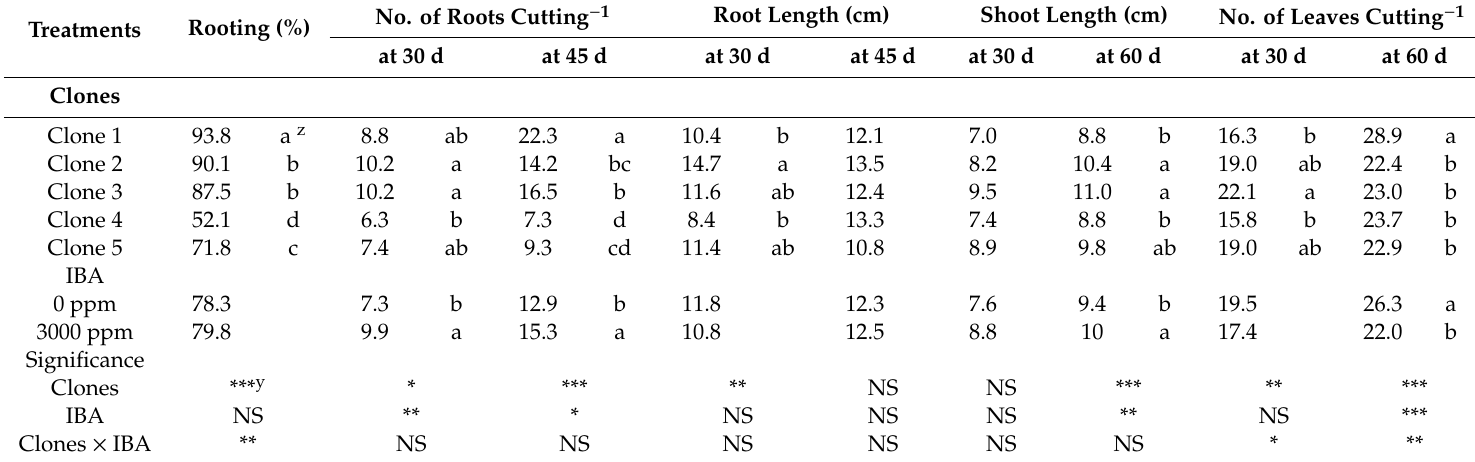
Table 2. E ff ects of indole-3-butyric acid (IBA) on rooting and growing of three-node cuttings of several clones of Nerium oleander . No. of Roots Cutting − 1 Treatments Rooting (%)